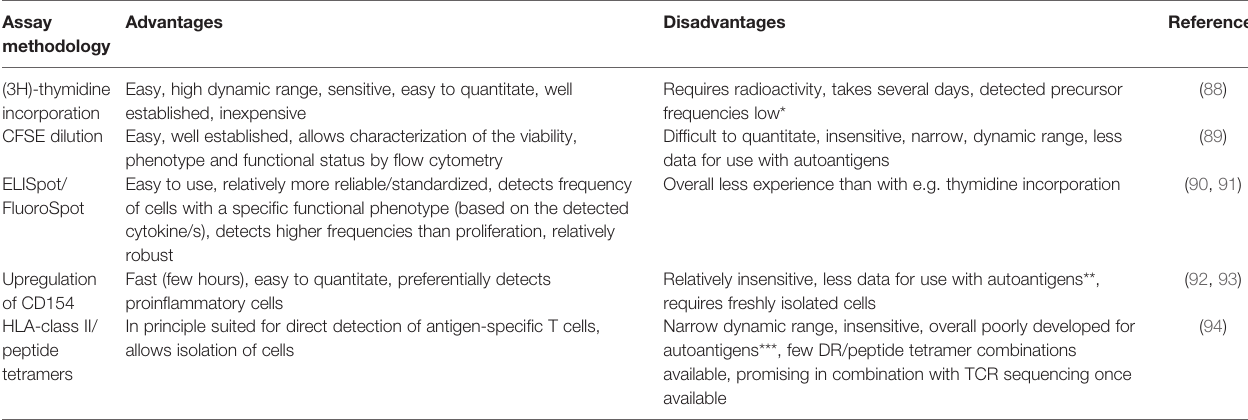
TABLE 1 | Assays for testing the frequency of autoantigen-speci fi c T